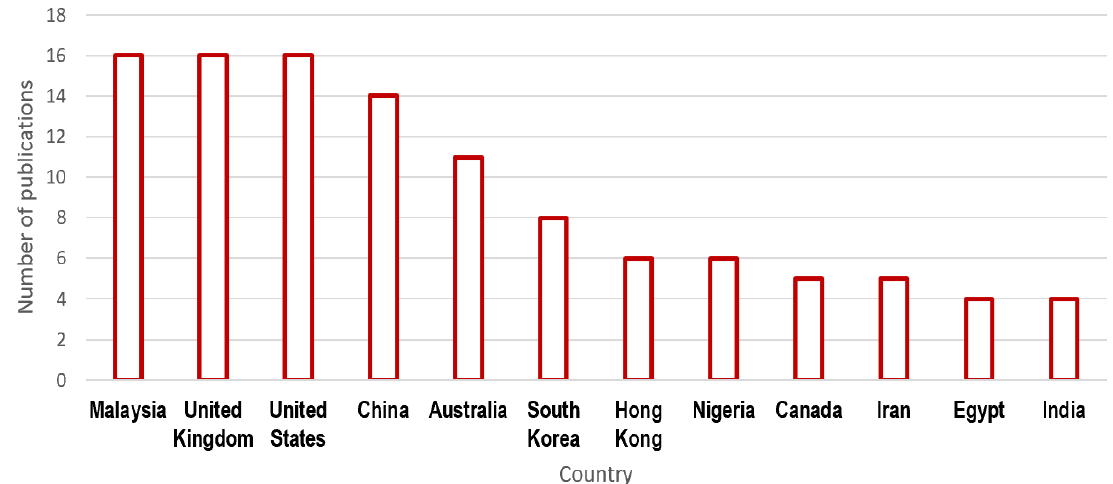
Figure 2. The distribution of the 104 journal articles by country from 2010 to 2021.